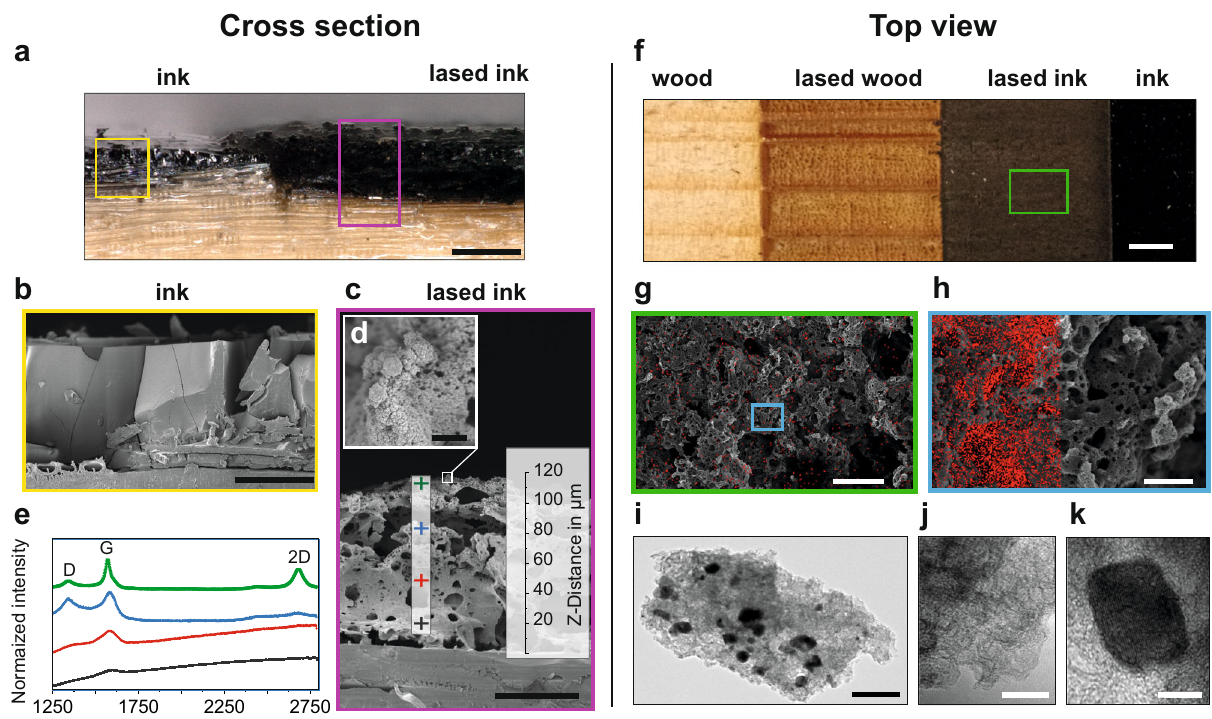
Fig. 3 Characterization of IC-LIG structures on wood: morphological and structural analysis. a Image showing lased and pristine ink-coated spruce veneer from the cross section perspective. SEM images of ( b ) pristine and ( c ) lased ink-coated spruce. The inset d is a magni fi ed image of the upper surface showing its nanostructure. In c , crosses of different colors indicate the typical Raman measurement points on samples treated with high fl uence parameters. The corresponding Raman spectra are shown in e . The top view optical image in f compares uncoated (left) with ink-coated (right) spruce after laser treatment. g , h SEM images (top view) showing the multi-hierarchical porosity of lased ink-coated spruce. i – k TEM images of the iron-carbon composite. The dark spots are due to the iron-rich phase. Scale bars: a 200 µ m, b and c 50 µ m, d 1 µ m, f 10 mm, g 100 µ m, h 25 µ m, i 20 nm, j , k 10